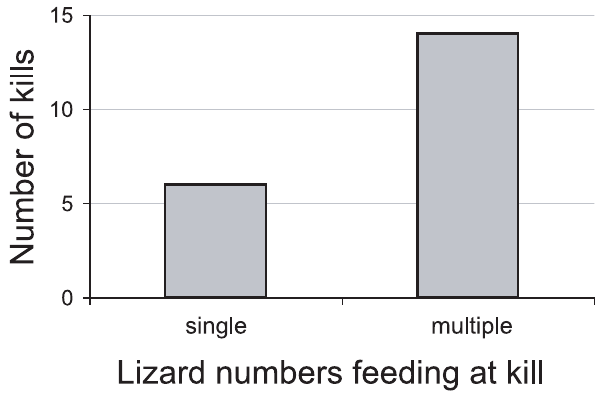
Figure 2. Communal feeding by dragons. Incidence of single versus multiple Komodo dragons feeding on large prey (Timor deer, wild pigs, water buffalo, and a Hawksbill sea turtle). Based on 20 independent observations of Komodo dragon feedings noted during fieldwork activities between 2002–2009.